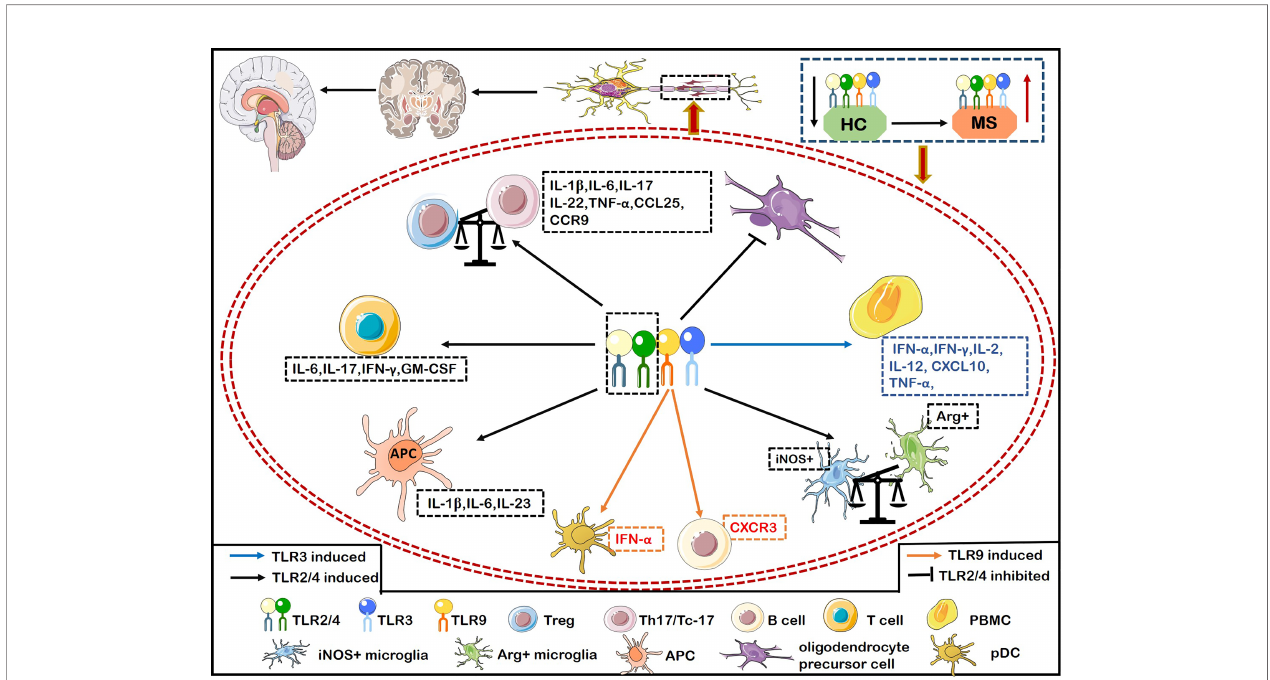
FIGURE 2 | The in fl ammatory role of TLRs causes demyelination and hinders myelin regeneration in MS. Activation of TLR2/4 on T cells from MS induces the secretion of IFN- g and IL-6, and activation of TLR2 alone also induces the secretion of IL-6, IFN- g , IL-17, and granulocyte-macrophage colony-stimulating factor (GM-CSF). Activation of TLR2/4 on APCs induces more productions of IL-1 b , IL-6, and IL-23. The expression of TLR2 on Treg breaks the balance of Treg/Th17 to exacerbate MS by transforming into a pro-in fl ammatory Th17-like phenotype. TLR2 is also up-regulated in oligodendrocytes of MS patients, which inhibits the maturation of oligodendrocyte precursor cell (OPC), resulting in the failure of remyelination in MS. The up-regulated expression of TLR2 on microglia increases the iNOS + phenotype and decreases the Arg + phenotype. The increased expression of TLR2/4 on Th17/Tc-17 cells promotes the up-regulation of IL-1 b , IL-6, IL-17, IL-22, and TNF- a . Meanwhile, TLR4 expression on Th17 promotes the secretion of IL-17, IFN-r, CCL25, and CCR9, thereby aggravating in fl ammation and in fi ltration into CNS. Activation of TLR3 on PBMCs upregulates the production of IFN- a , IFN g , IL-2, IL-12, TNF- a and CXCL10 to aggravate MS. Activation of TLR9 on B cells signi fi cantly increases the expression of T-bet to enhance the pathogenicity of B cells, and up-regulates the expression of CXCR3, thus promoting the in fl ammatory response of peripheral blood B cells and in fi ltrating into the CNS in